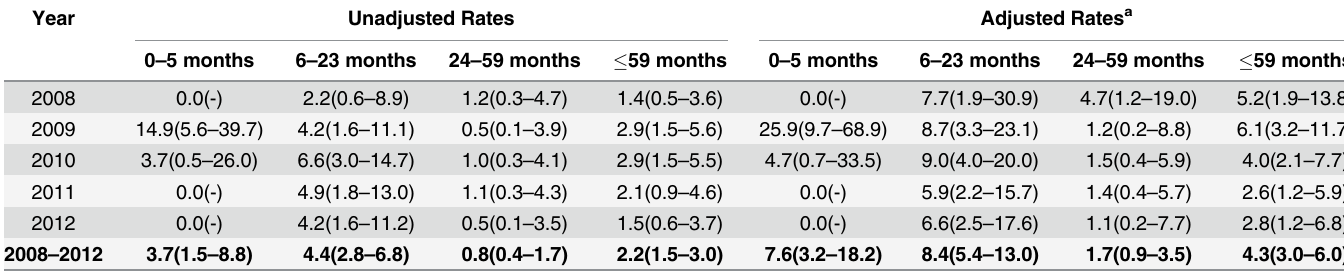
Table 3. Rate of Hospitalizations a (Lwak) Attributable to Influenza per 1000 Person-Years, by Age Group and Year, 2008 – 2012.